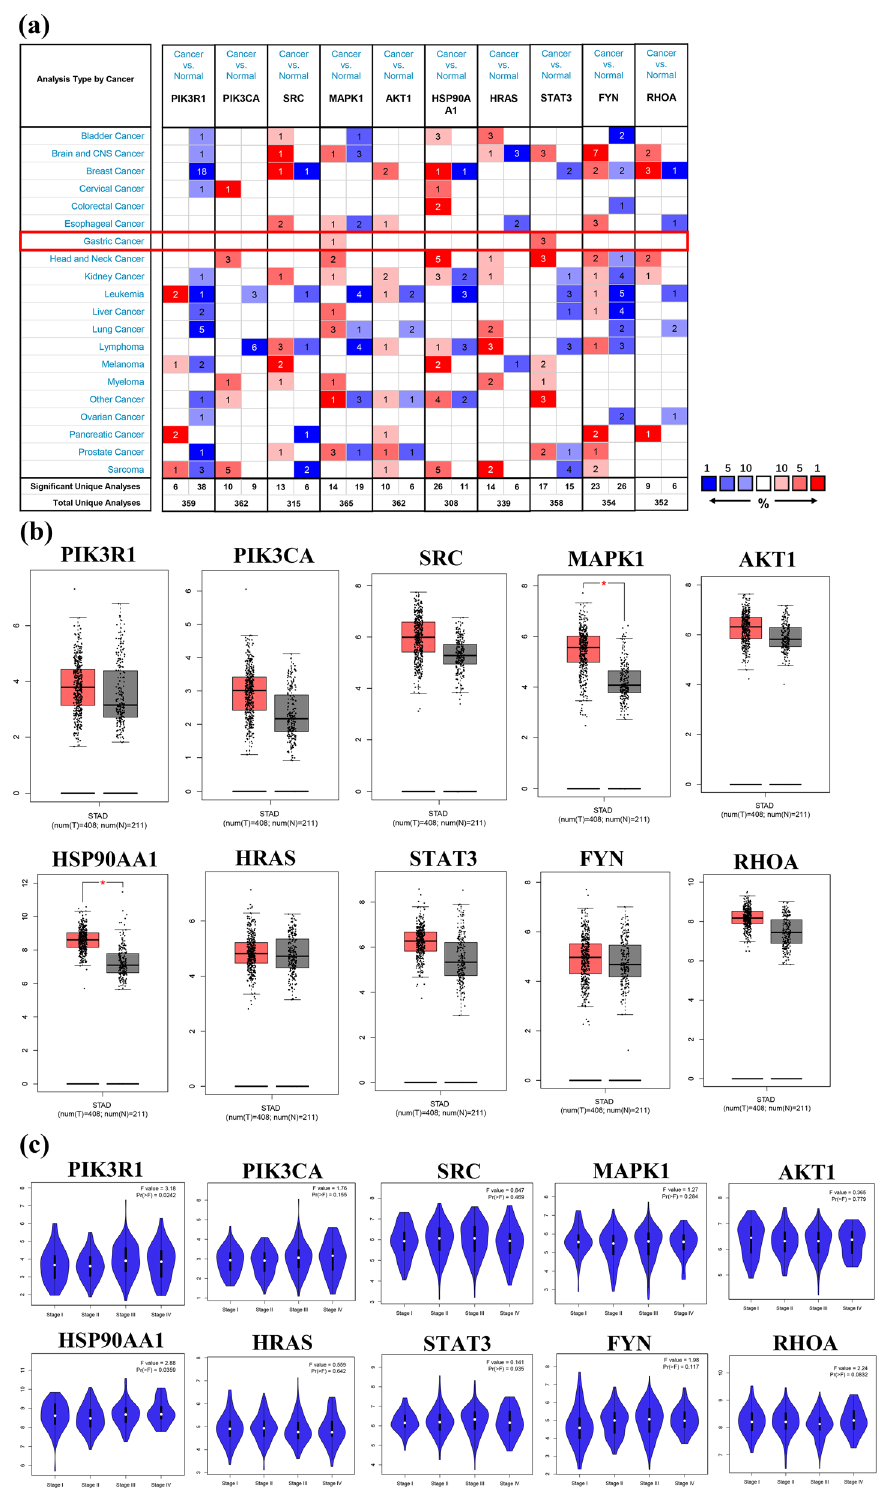
Figure 9. The mRNA expression levels of hub genes in different databases. ( a ) Oncomine analysis of hub gene mRNA expression levels in different cancers. Compared with normal tissues, the red box indicates the overexpression of the target gene in tumour tissues, while the blue box indicates the downregulation of the gene. The intensity of expression is expressed in shades of colour. ( b ) Boxplot of hub gene mRNA expression levels in the GEPIA database. Red represents GC tissue, and grey represents normal gastric tissue. ( c ) Stage plot of hub gene mRNA expression level and pathological stage in the GEPIA